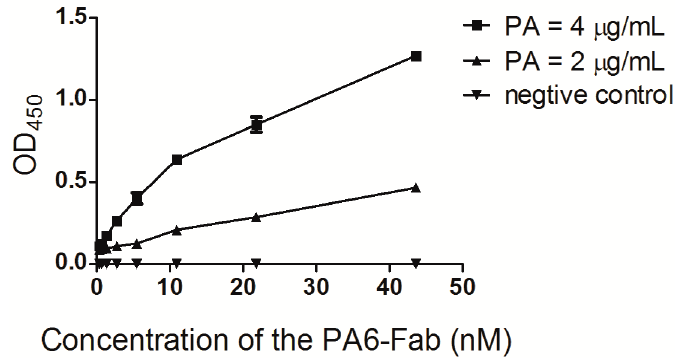
Figure 5. Immunoreactivity of PA6-Fab to anthrax PA. The immunoreactivity was measured by ELISA. The relationship of the concentration of the PA6-Fab and the absorbance at 450 nm were plotted by GraphPad Prism software 5.0 (GraphPad Software, San Diego, CA,